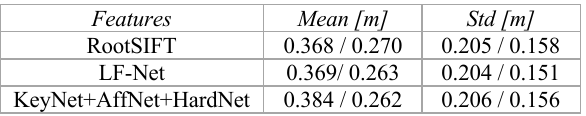
Table 3: Mean and standard deviation of the cloud-to-cloud differences. The second value is the average of the 4 sub-areas including only buildings (Figure 3b).